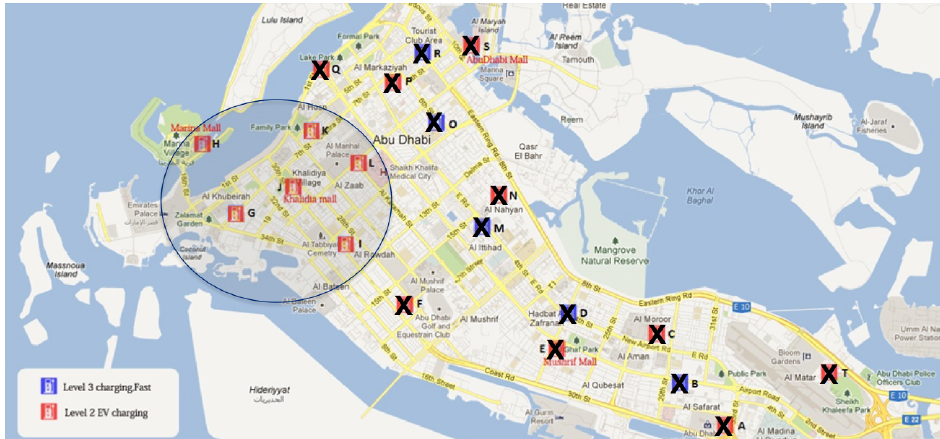
Figure 5. Limited Dense Charging System Design Map.